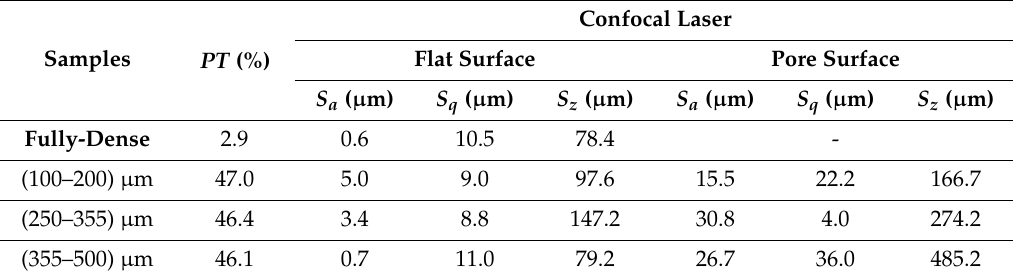
Figure 2. SEM, confocal microscopy and micro-computed tomography (M-CT) images of porous substrates for the different ranges of spacer particle size (100–200, 250–355 and 355–500 µm) showing the surface and pore morphology. Common scale-bar for each type of image. Table 1. Total porosity measured by image analysis (IA) and roughness parameters determined using confocal laser microscopy of fully-dense and porous substrates.